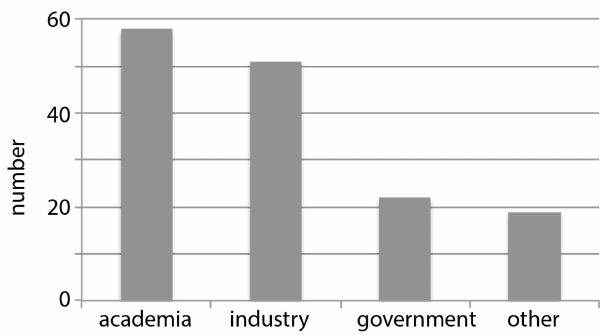
Figure 1. Distribution of survey